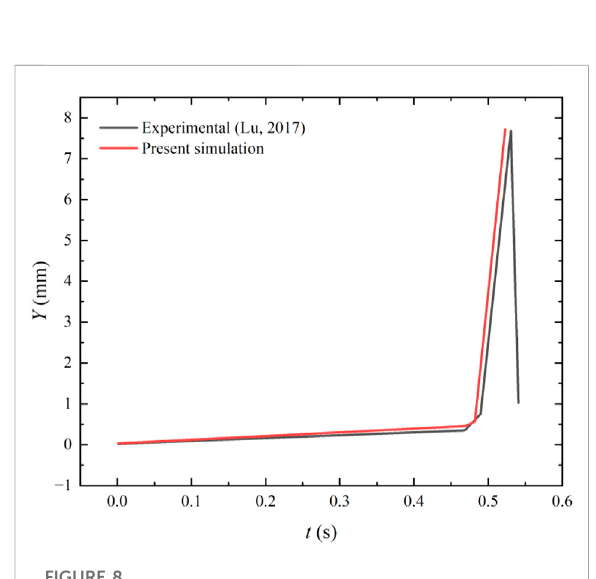
FIGURE 8 Comparison of de fl ection of present simulation with the experimental (Lu, 2017) results.